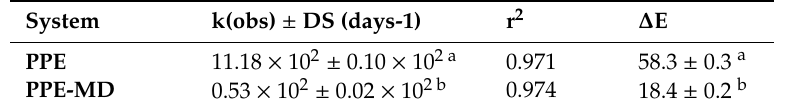
Table 4. Anthocyanin degradation rate constant at 60 ◦ C for PPE and PPE-MD and their color di ff erence values.